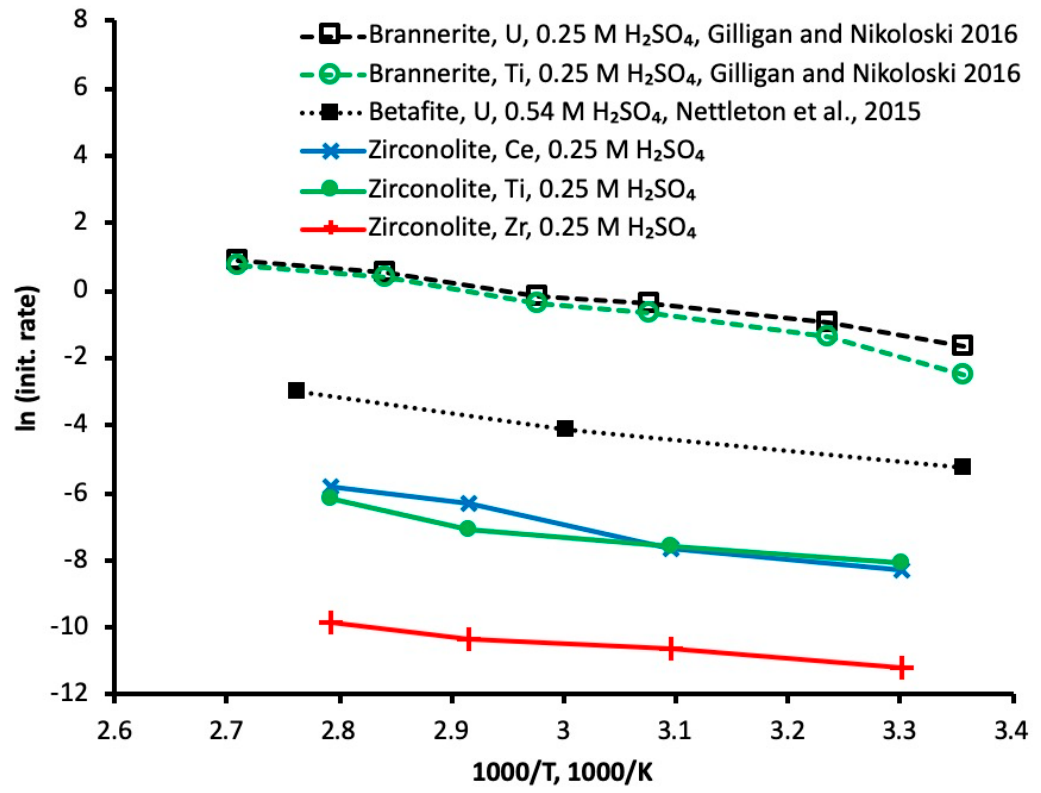
Figure 10. Arrhenius plots for the extraction of various elements from brannerite, betafite and zirconolite in sulphuric acid.